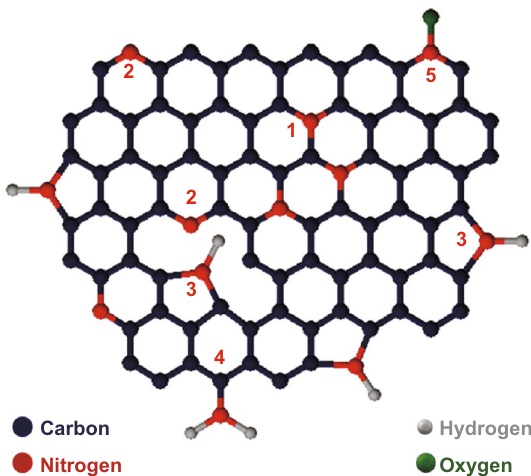
Fig. 1 Possible nitrogen configurations in graphene lattice, labelled as (1) graphitic N, (2) pyridinic N, (3) pyrrolic N, (4) amine, and (5) N-oxides of pyridinic